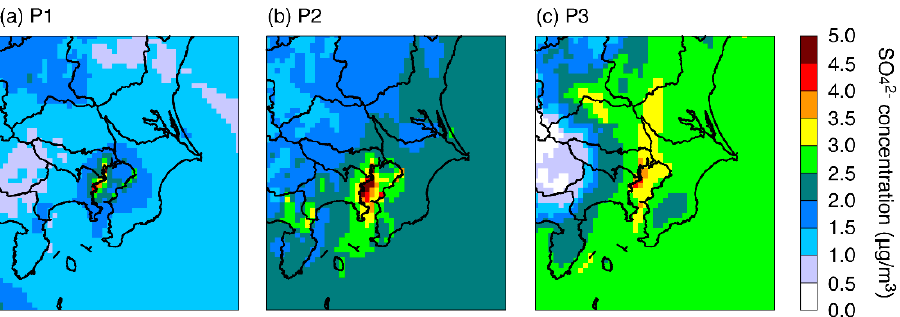
Figure 5. Spatial distribution of SO 42– concentrations simulated by the CMAQ base-case simulation averaged over ( a ) P1, ( b ) P2, and ( c ) P3 for domain 4.